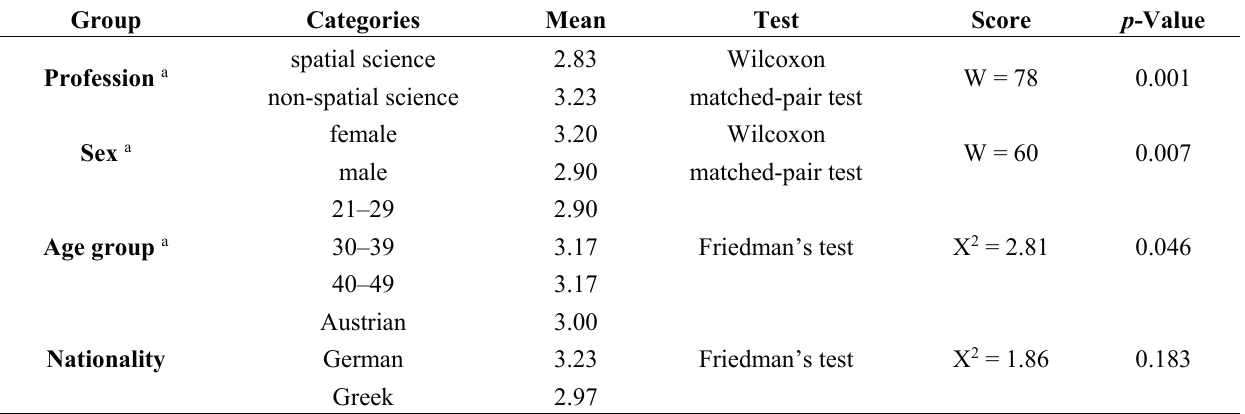
Table 2. Significance of differences in similarity perception between the categories of each group. a The groups’ categories are statistically different at the 0.05 significance level.